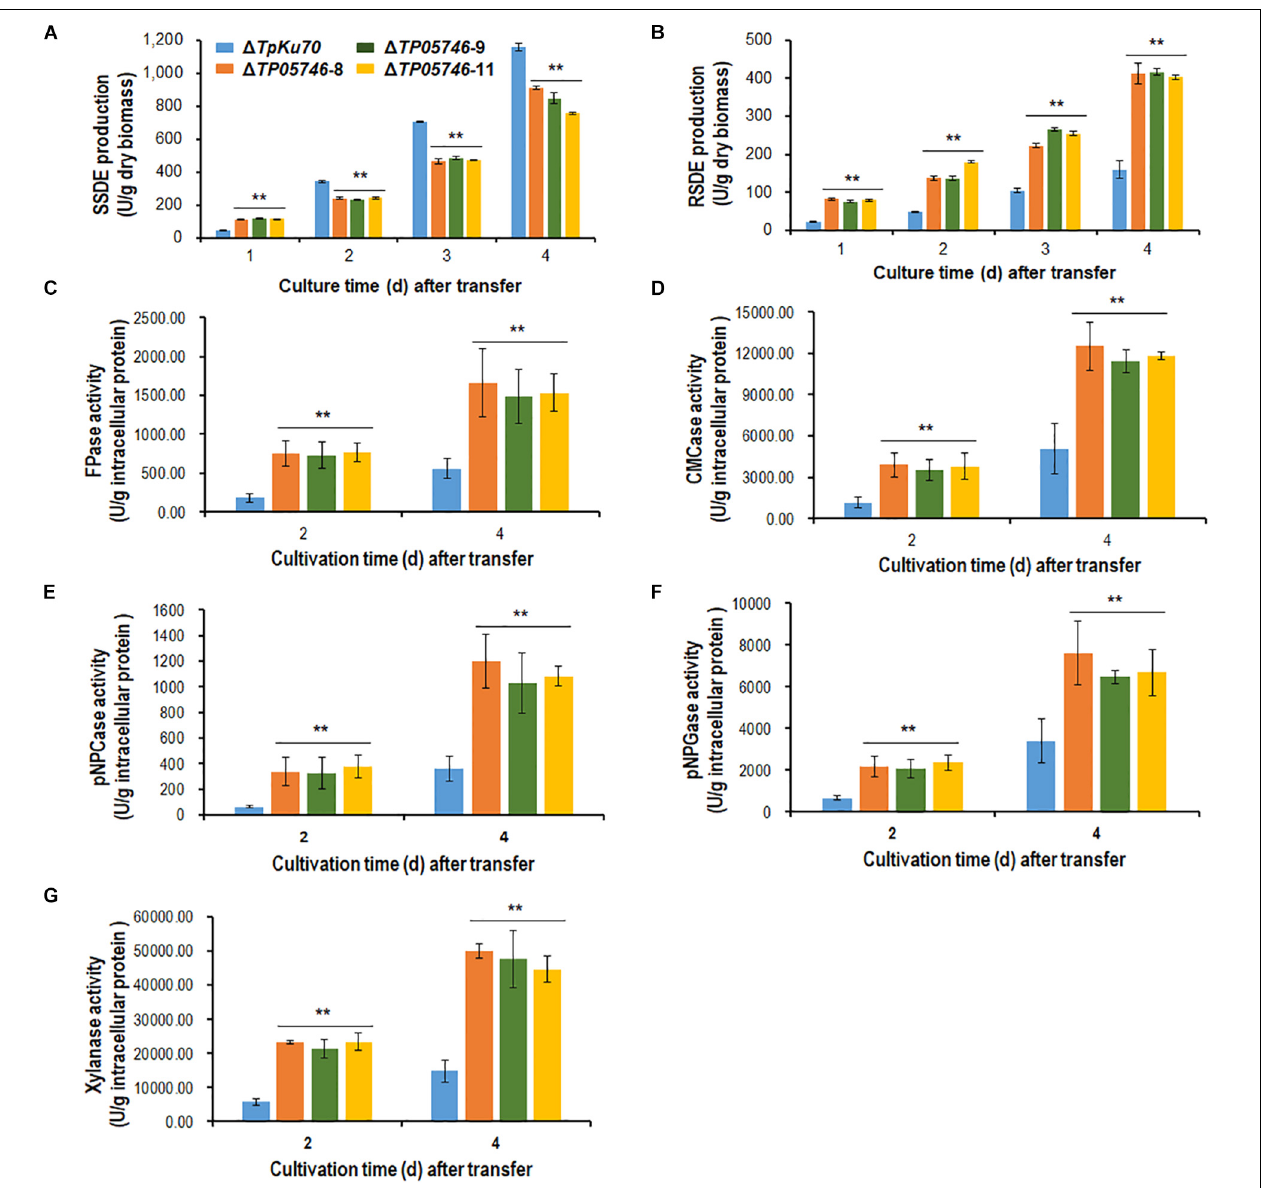
FIGURE 2 | Plant-biomass-degrading enzymes production by T. pinophilus mutant (cid:49) TP05746 and the parental strain (cid:49) TpKu70 . Crude extracts were produced from T . pinophilus strains cultured after a transfer from glucose medium to SCS medium (A,B) or WA medium (C–G) for 1–4 days. (A) SSDE production. (B) RSDE production. (C) FPase production. (D) CMCase production. (E) pNPCase production. (F) pNPGase production. (G) Xylanase production. All experiments were performed with three independent biological replicates. Each data point is mean ± SD. ∗∗ p ≤ 0.01 indicates differences between the deletion mutant (cid:49)